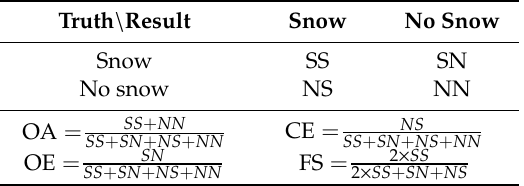
Table 1. Description of the confusion matrix and definition of the validation metrics.